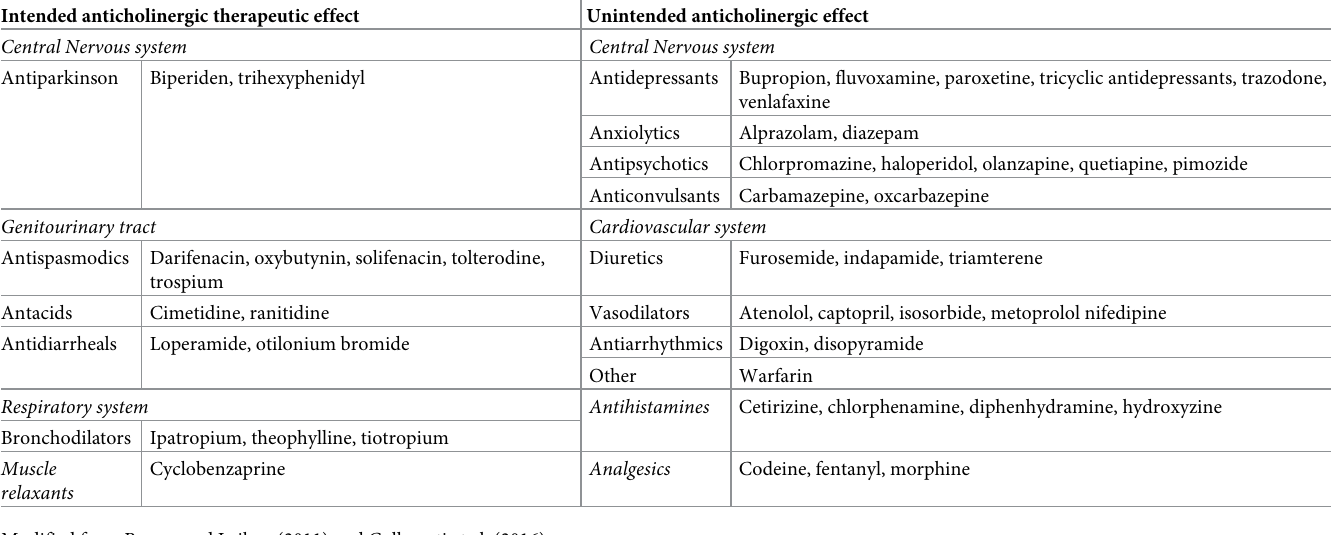
Table 1. Examples of common medications with anticholinergic properties in the elderly general